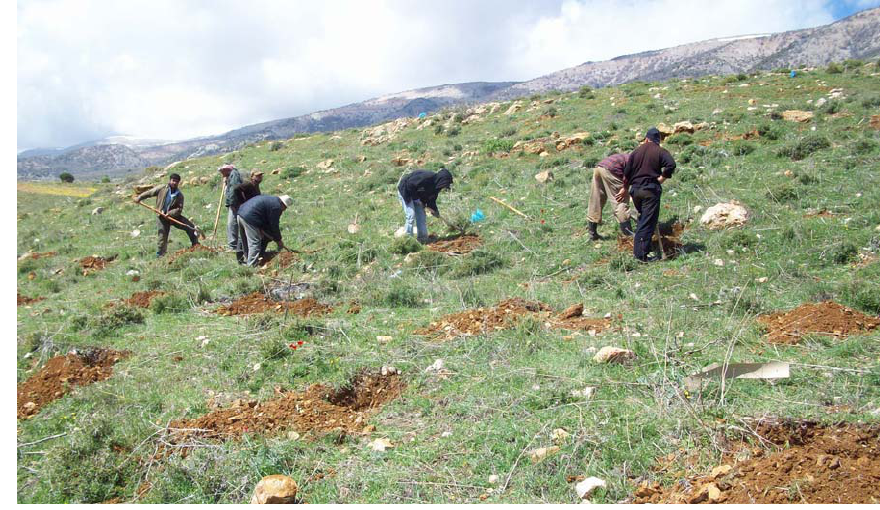
Figure 3. Hand preparation of Lala site.